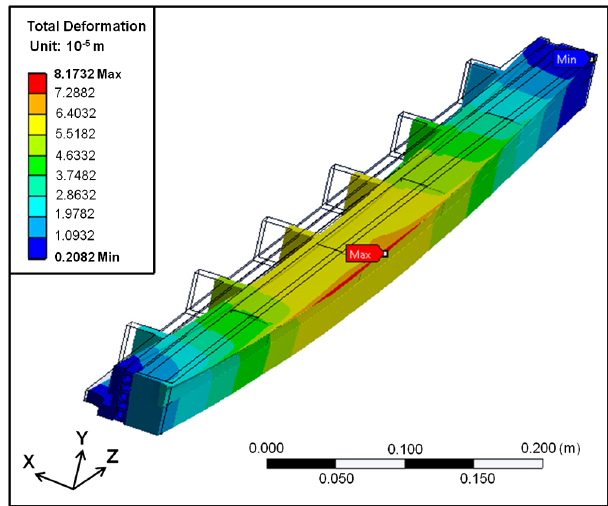
FIG. 25. Total deformation of the collimator jaw assembly resulting from the beam impact. It should be noted that the copper housing, the cooling pipes and the back stiffener must exhibit the same deformation as the jaw inserts as the latter are not allowed to slip in the FEM